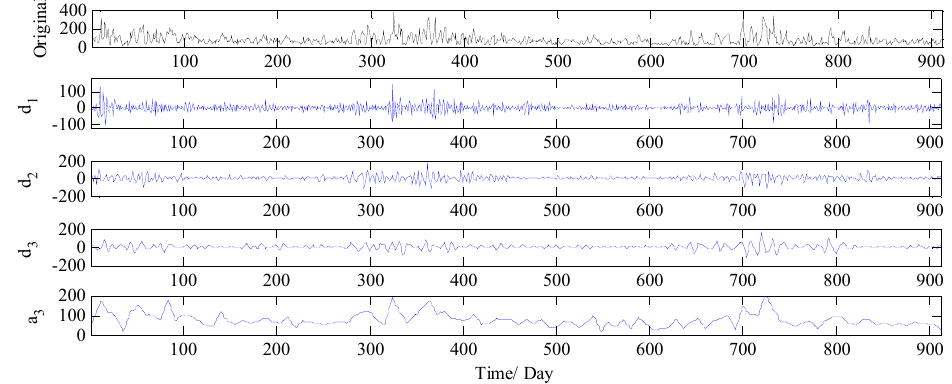
Figure 14. Decomposition results of PM 2.5 concentration series by WT (Tianjin).